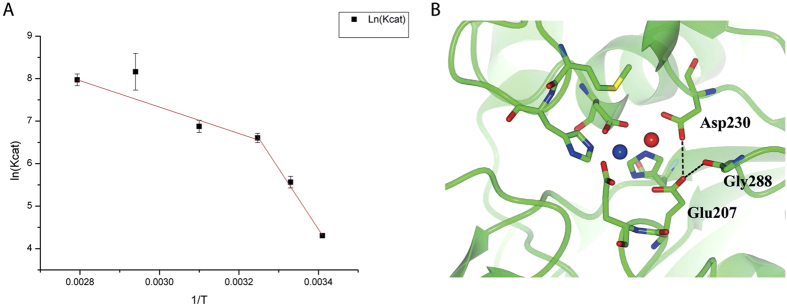
Temperature dependence of PfTET3 activity.(A) Arrhenius plot of PfTET3Zn between 20 °C–85 °C. The breakpoint is at 35 °C, suggesting a reduced flexibility of PfTET3Zn in the active site and at the interfaces. The non-linear profile indicates cold inactivation by rigidifying the oligomeric interface. (B) PfTET3 active site. Blue and red spheres stay for Co2+ and Zn2+, respectively. For the sake of the clarity, only residues involved in salt bridges with Glu207 are labeled. The dashed lines are the electrostatic interactions between Glu207 and Gly288/Asp230. Such interactions increase the pKa of Glu207 and decrease the enzymatic activity of PfTET3 at 20 °C.